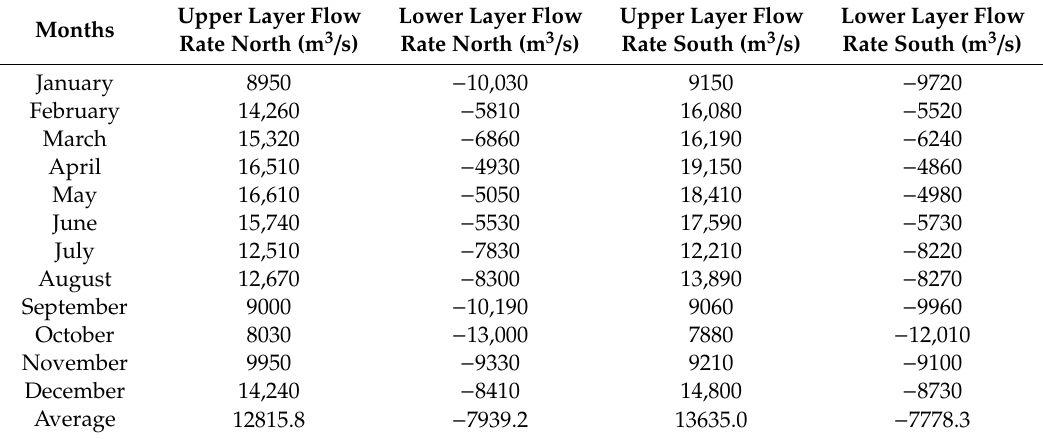
Figure 7. Upper ( a ) and lower ( b ) flow rate values of the northern part of the strait.